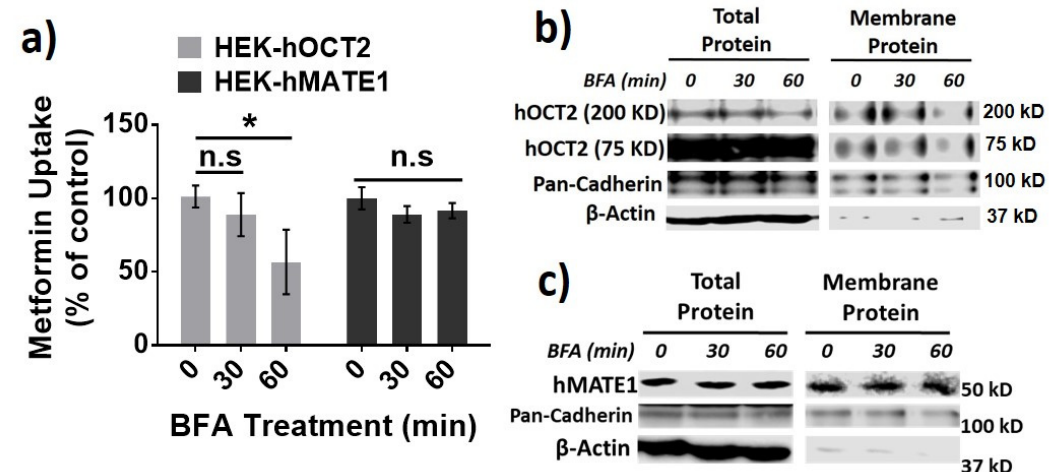
Figure 4. Effect of brefeldin (BFA) treatment on the membrane expression and function of hOCT2 and hMATE1. ( a ) Cellular uptake of metformin in HEK-hOCT2 and HEK-hMATE1 cells after exposure to BFA at indicated times. ( b ) IB analysis of total and membrane fraction of hOCT2 in HEK-hOCT2 cells after exposure to BFA at indicated times. ( c ) IB analysis of total and membrane fraction of hMATE1 in HEK-hMATE1 cells after exposure to BFA at indicated times. For b and c, pan-cadherin is served as the positive control and β -actin as the negative control for membrane proteins. For a, data are presented as mean ± S.D.; * p < 0.05; n.s., no significance.